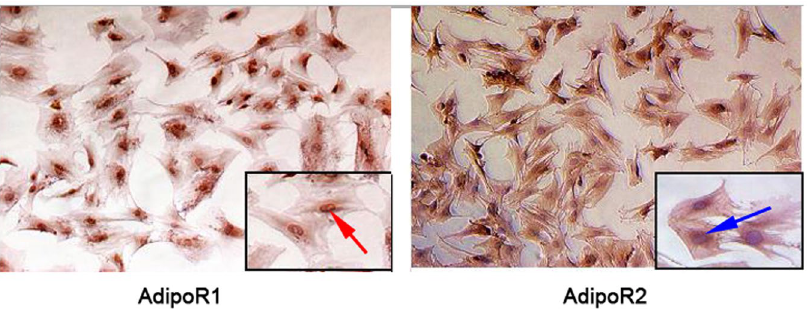
Figure 4. AdipoR1 and AdipoR2 expressed in BMSCs. AdipoR1 and AdipoR2 were dyed brown (red arrow), and the nucleus was stained with haematoxylin (blue arrow). AdipoR1 was expressed in the cytoplasm, cytomembrane and nucleus, while AdipoR2 was expressed only in the cytoplasm and